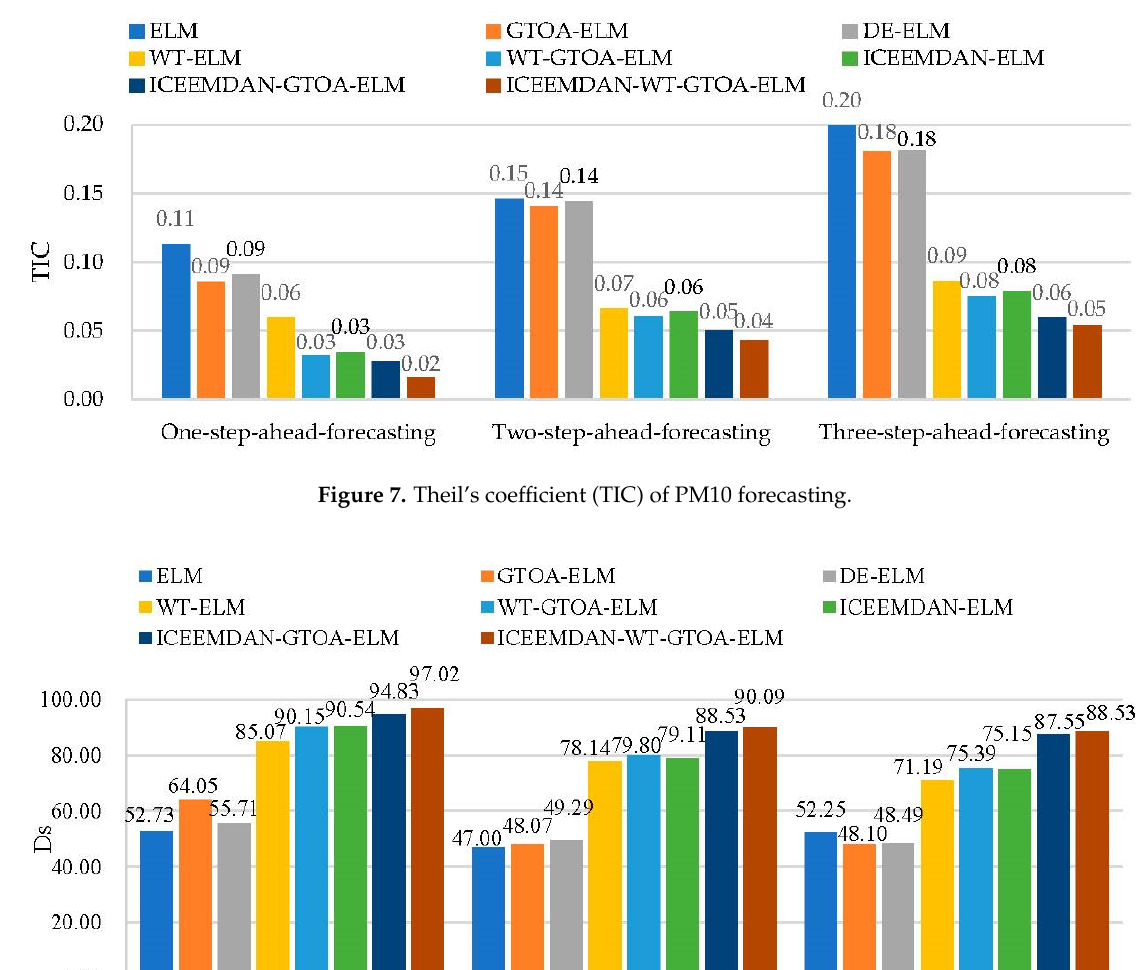
Figure 6. Normalized root mean square error (NRMSE) of PM10 forecasting.